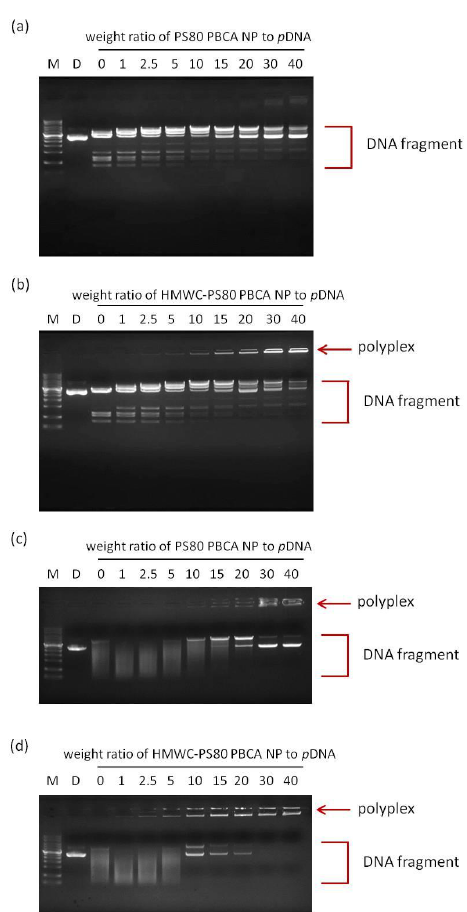
Figure 7a,b shows the agarose gel electrophoresis of PS80 PBCA NP/BDNF p DNA and HMWC-PS80 PBCA NP/BDNF p DNA polyplexes respectively after Bam HI/Hind III digestion. When the BDNF p DNA is mixed with PS80 PBCA NP or HMWC-PS80 PBCA NP, interaction with the nanoparticles will lead to the formation of polyplexes, the stability of which will influence the degree of digestion by the nucleases. The polyplex made with PS80 PBCA NP appeared less stable in the range of the weight ratio tested as free BDNF p DNA and its cleaved products were readily seen. On the other hand, the polyplex formed with HMWC-PS80 PBCA NP began to show a poorly electrophoretic band from a weight ratio of 10 and beyond, which indicated stabilization of the BDNF p DNA in the polyplex preventing nuclease digestion. Similarly, the agarose gel electrophoresis by the addition of DNase I into the PS80 PBCA NP/BDNF p DNA and HMWC-PS80 PBCA NP/BDNF p DNA polyplexes are shown in Figure 7c,d. Under these circumstances, the existence of stable polyplexes could only be seen in the former at a weight ratio of 10 and beyond, whereas, in the latter, stable polyplexes could be found at a weight ratio from as low as 2.5. Therefore, Int. J. Mol. Sci. 2021 , 22 , x FOR PEER REVIEW the polyplex with a weight ratio of 15:1 was chosen in the following experiments.